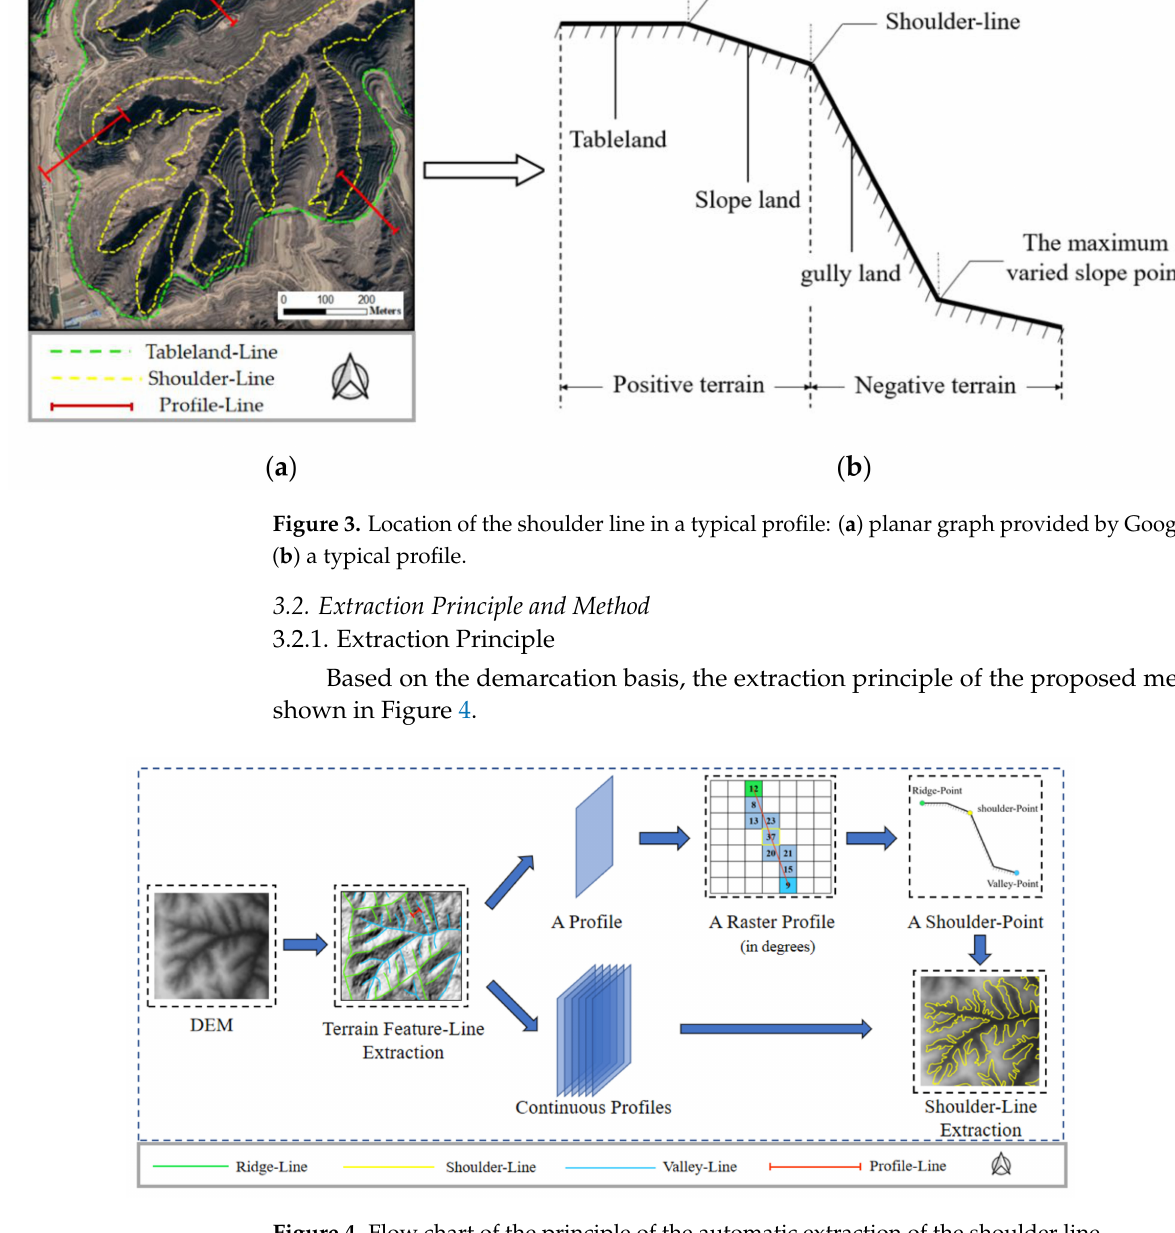
Figure 4. Flow chart of the principle of the automatic extraction of the shoulder